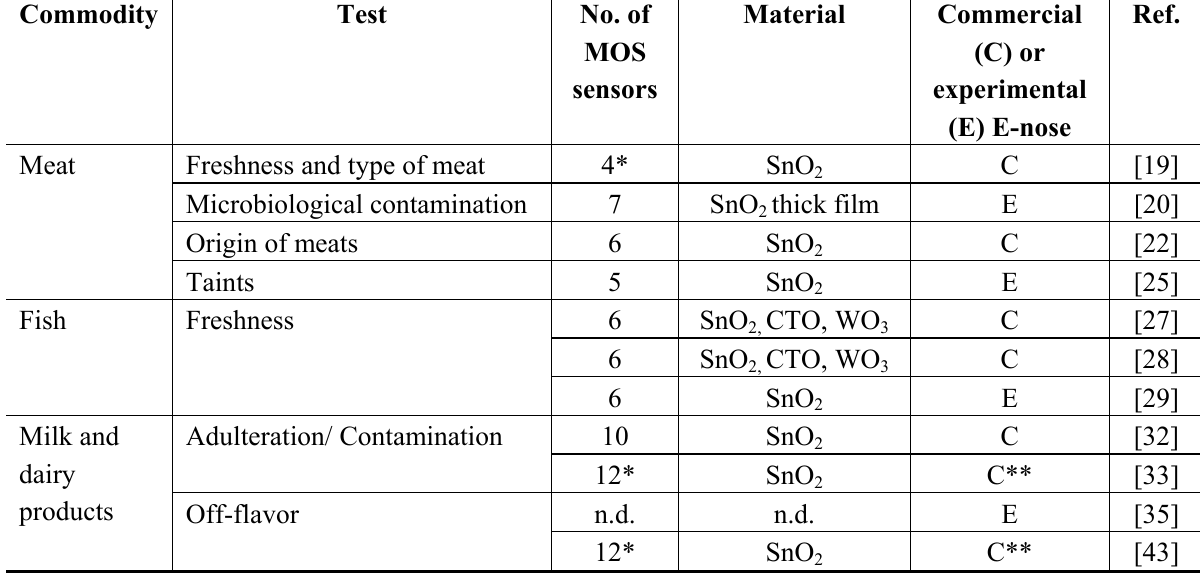
Table 1. Application of MOS based E-noses in the food industry, sensors used and